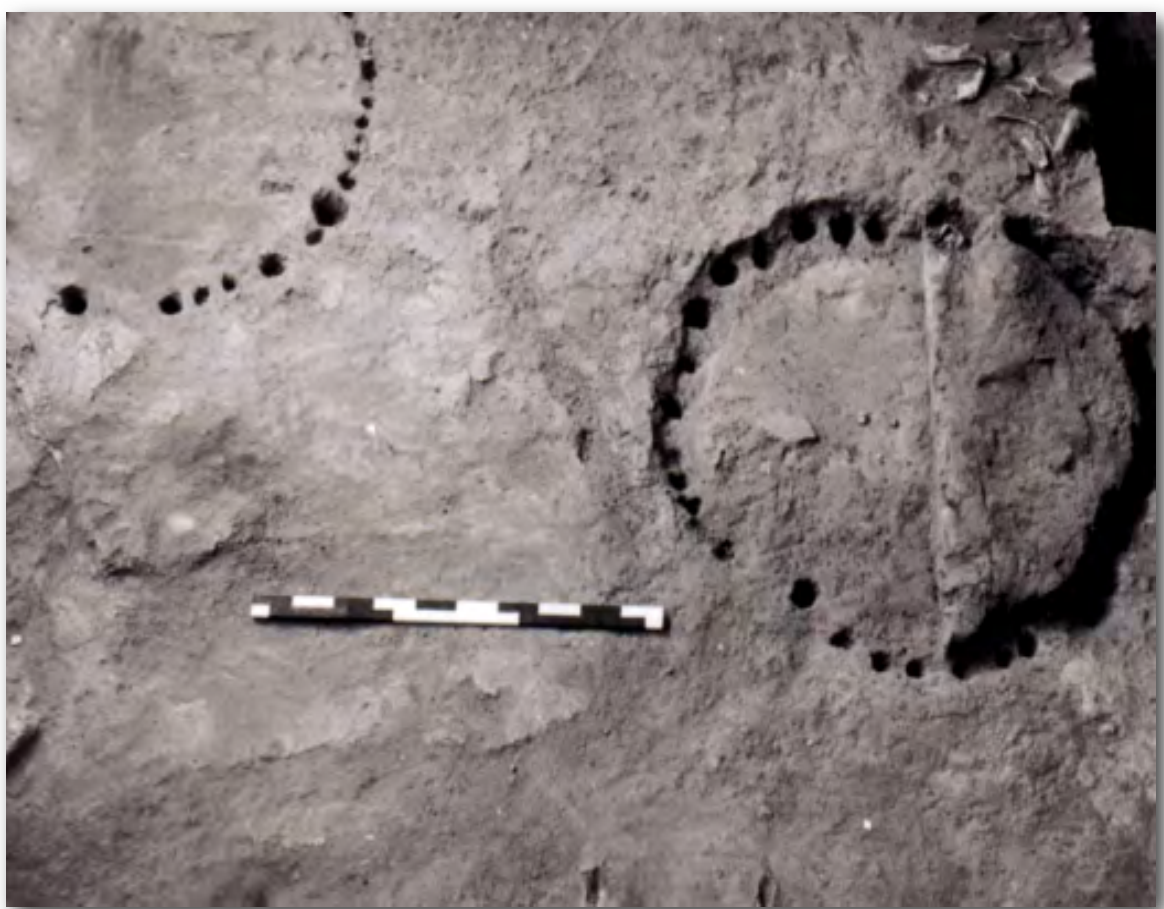
Figure 13. Two small circular pole and daub wall bases without floors in Layer 9(i) in Excavation F4 on the Southern Terrace at Mapungubwe (Meyer 1998:148, Figure